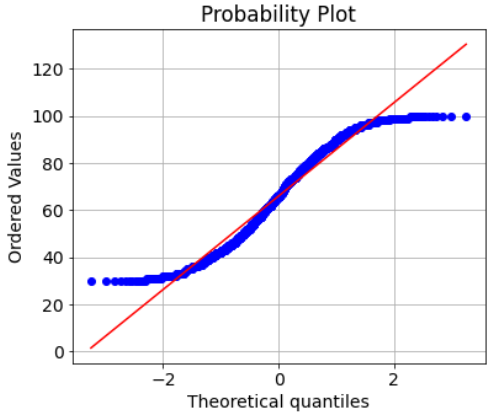
Figure 5. Parametric test to observe the normal distribution of the dataset. A null hypothesis is created, i.e., a significant correlation between two features. The null hypothesis is rejected if the p-value is smaller than the significance value, i.e., 0.05. We used different features, i.e., mqtt.client and mqtt.conack.flags, to the Mann-Whitney U Test that gives the p -value of 0.04, which is smaller than the significance. Hence, it rejects the null hypothesis is rejected as there is no strong correlation between mqtt.client and